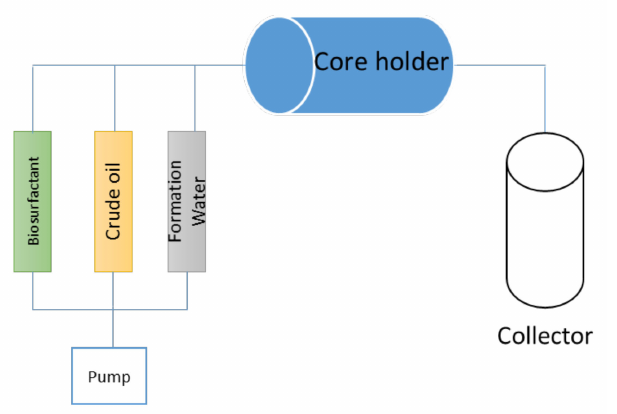
Figure 1. Scheme of core flooding equipment.